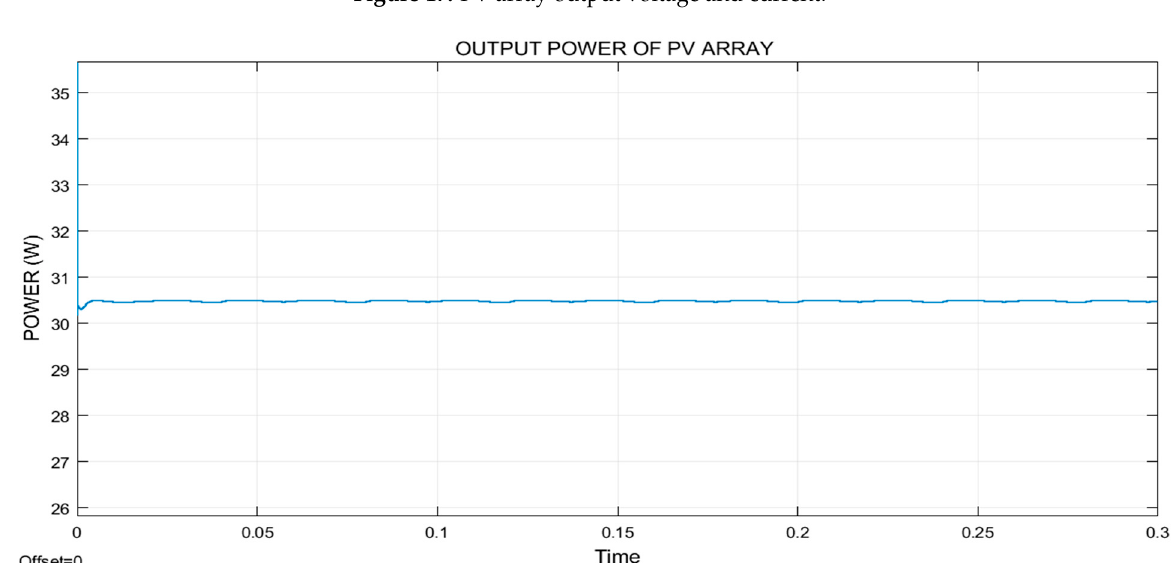
Figure 18. PV array output power.